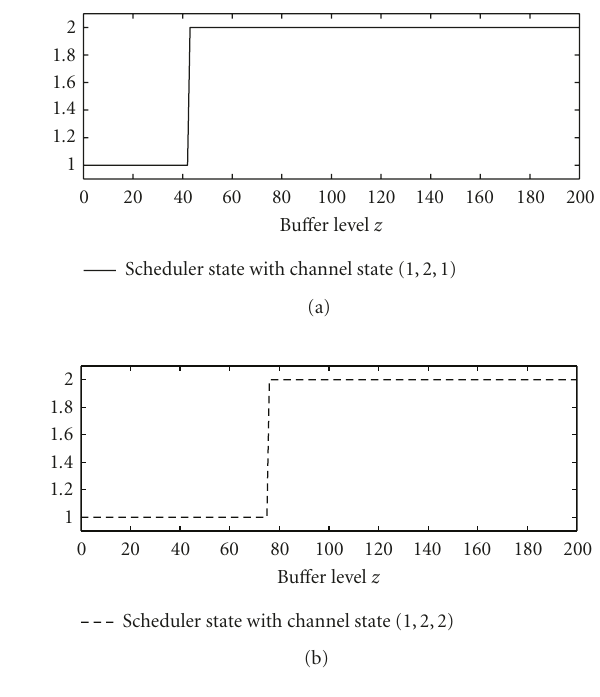
Figure 11: The state of the scheduler switching between 1 and 2.